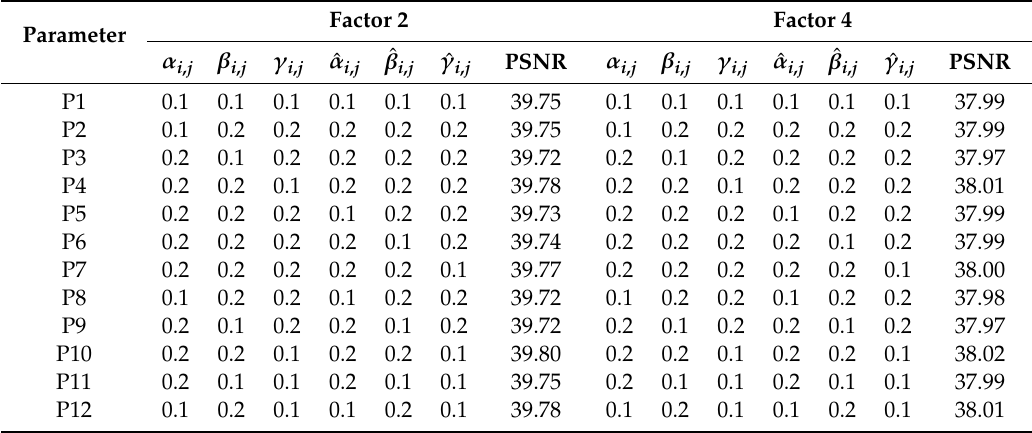
Table 5. The impact of parametric values on the peak signal-to-noise ratio (PSNR) values.